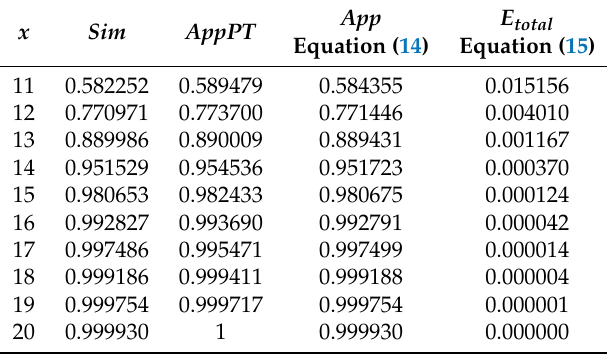
Table 3. MA-like(q = 2) model: m = 20, T = 1000, X i = 0.3 Y i + 0.1 Y i + 1 + 0.5 Y i + 2 , ITER app = 10 6 , ITER sim = 10 5 .